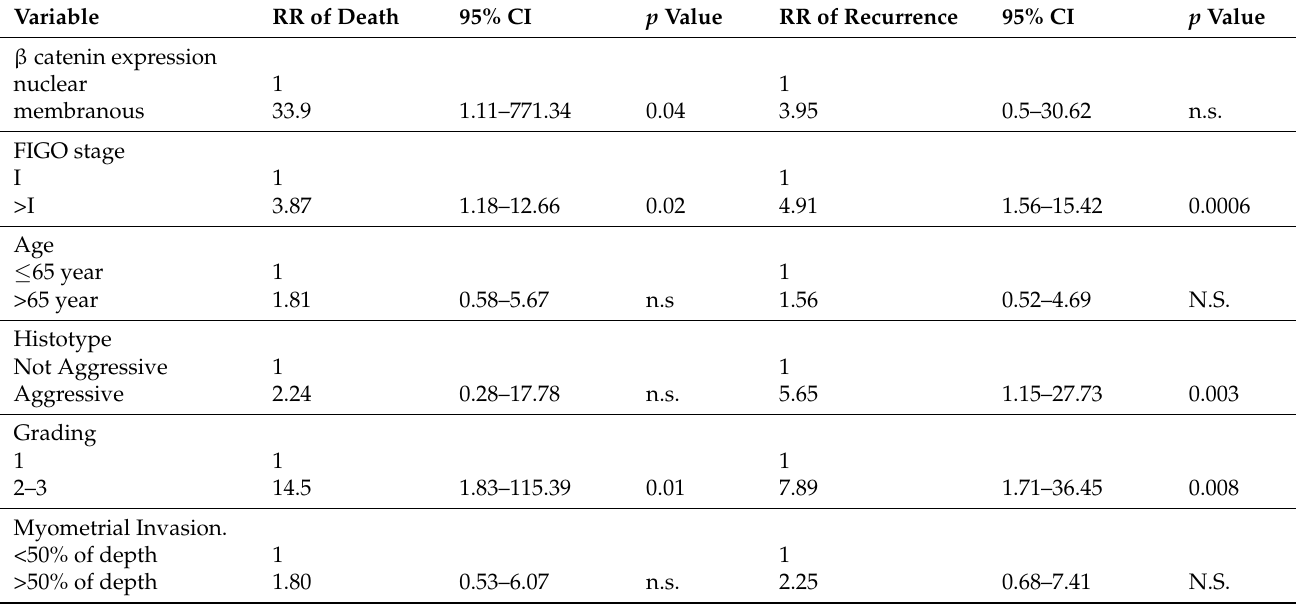
Figure 2. Kaplan–Meier plot of disease-related survival ( A ) and disease-free survival ( B ) according to β -catenin expression patterns (nuclear vs. membranous). The 5-year disease-related survival (drs) rate was 100% for specimens expressing nuclear β -catenin, compared with 73.8% of specimens expressing membranous β -catenin ( p ≤ 0.04), whereas cases expressing nuclear β -catenin showed a 5-year disease-free survival (dfs) rate of 90.9% compared with 67.4% of cases expressing membranous β -catenin, although the statistical significance was not reached ( p = 0.15). Table 3. Significant predictors of clinical outcome in 74 patients with endometrial adenocarcinoma, according to the Cox Univariate Analysis for disease-related (drs) and disease-free survival (dfs).